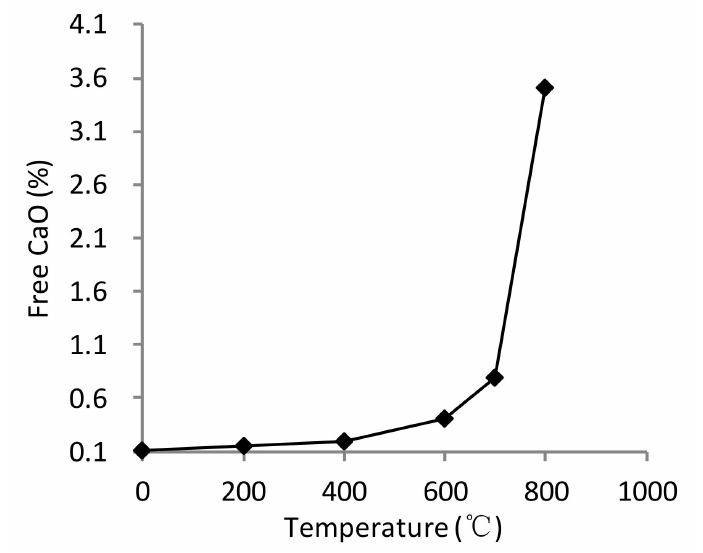
Figure 4. Free calcium oxide content in